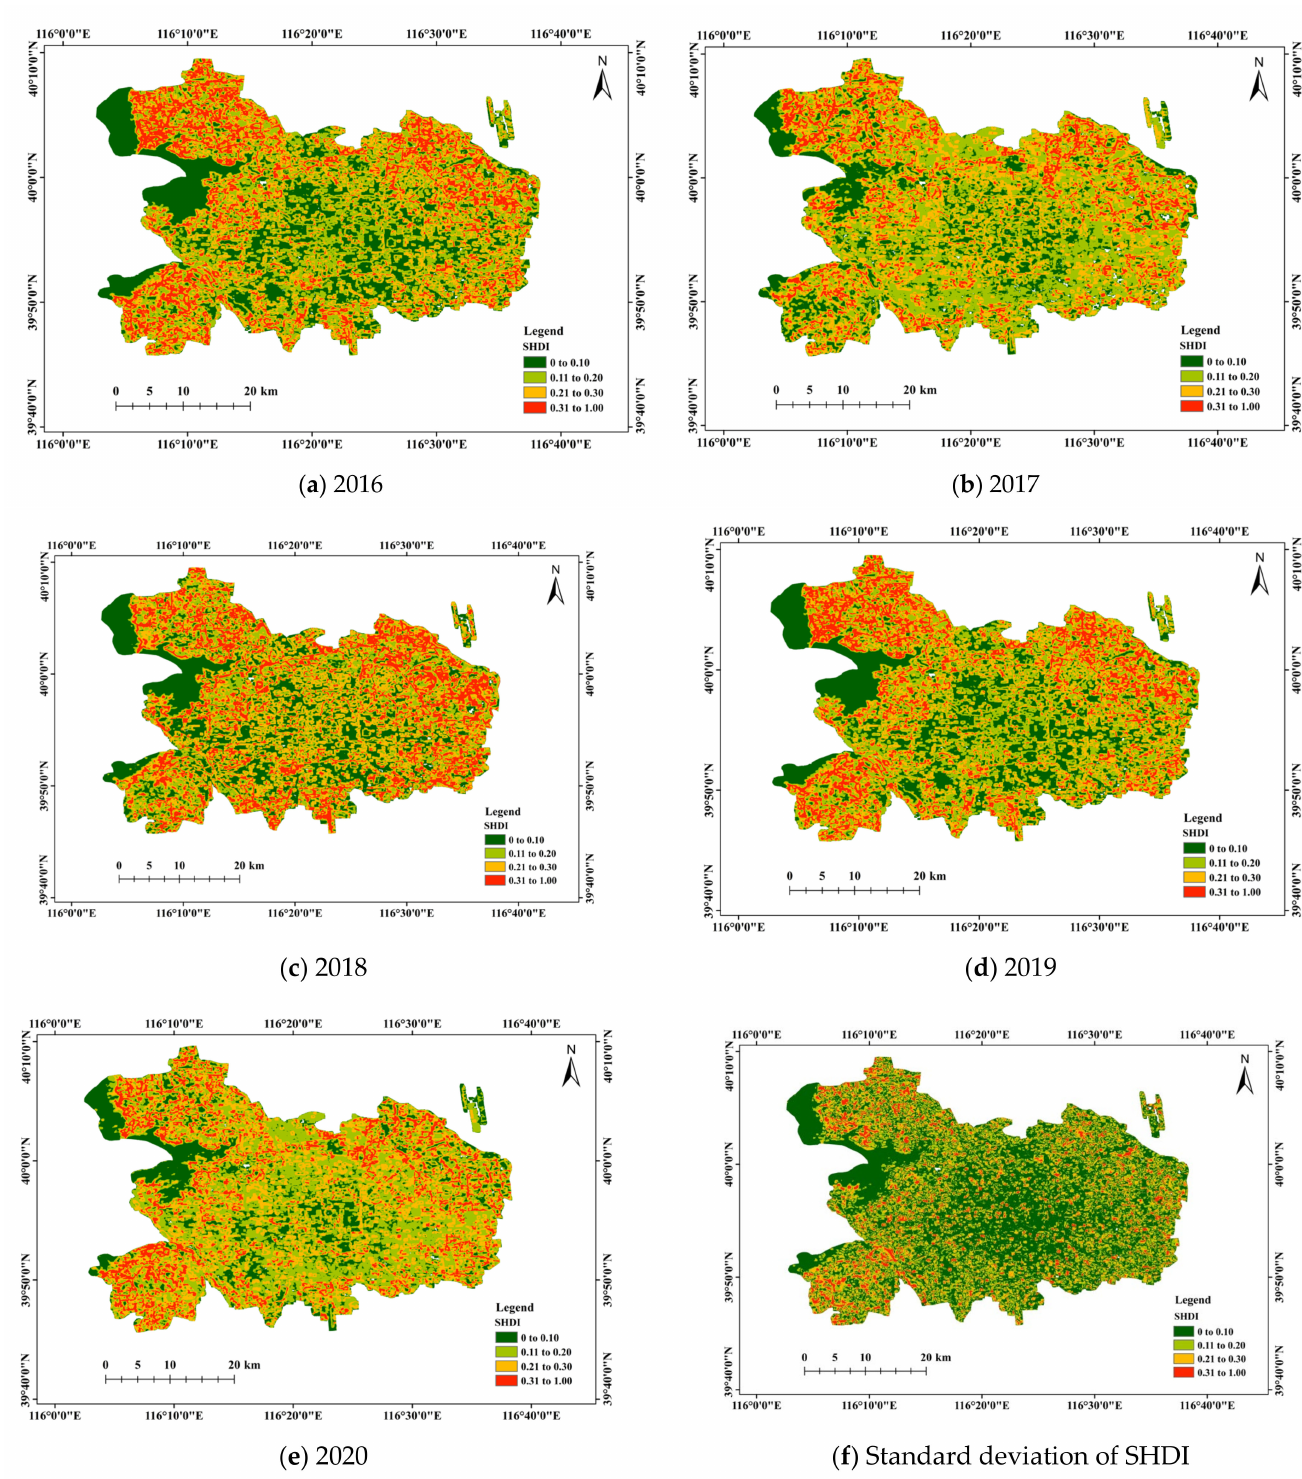
Figure 10. SHDI distribution maps for study area from